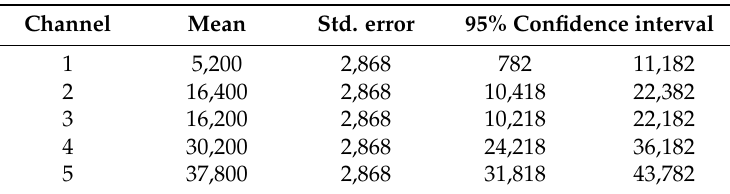
Table 2. Results from the ANOVA test. Estimates for the different channels with the expected upper and lower limits for adhered cells per visual field in each channel.